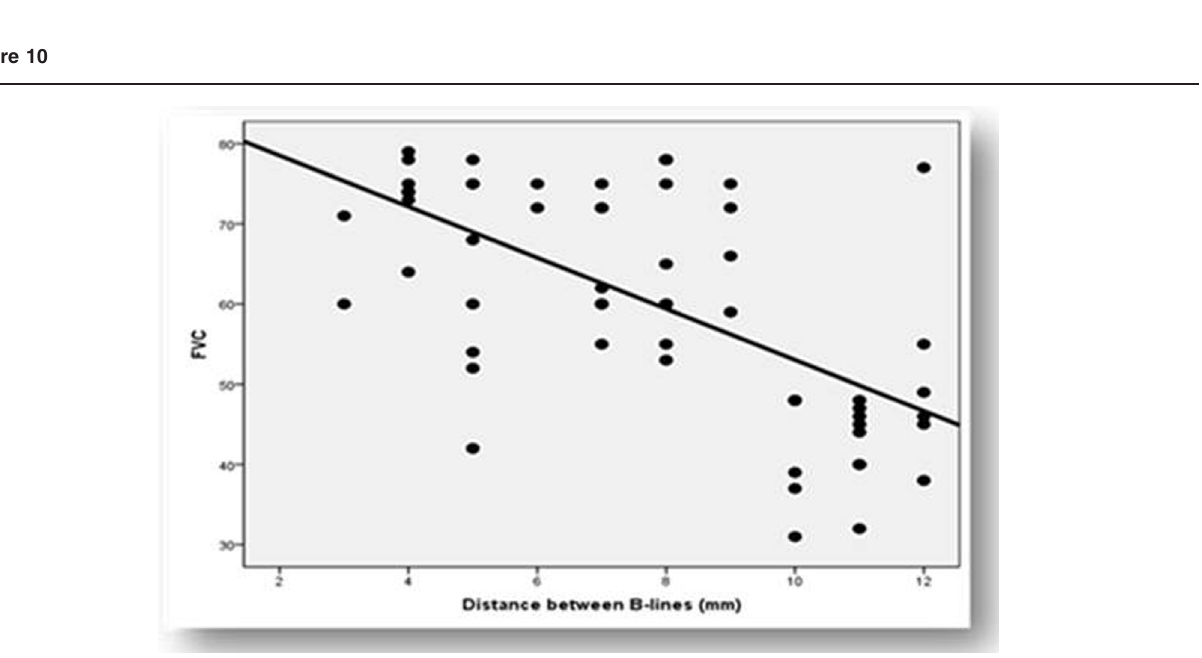
The relation between B-line distance and forced vital capacity